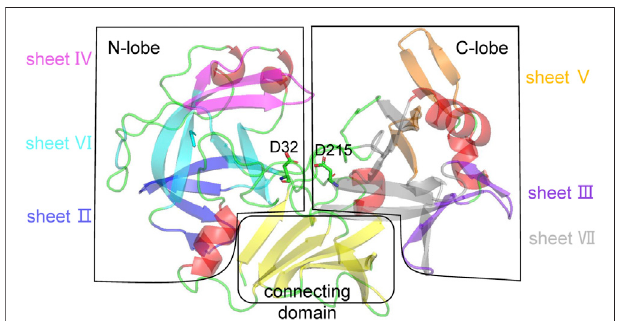
FIGURE 1 | Structural analysis of pepsin. Pepsin is divided into three regions:N-lobe, C-lobe,and connectingdomain. IntheN-lobe, ß -strands can bedividedintothreelayers:sheets IV(magenta),VI(cyan),andII(blue)thatare orthogonally packed. In the C-lobe, ß -strands can be divided into two orthogonalpackingsheets,VII(grey)andIII(purpleblue), andarather separate sheet V (orange). The connecting domain is composed of a six-stranded antiparallel interdomain ß -sheet (yellow). Other secondary structures, a -helices and loops are shown in red and green. The catalytic dyad is represented by